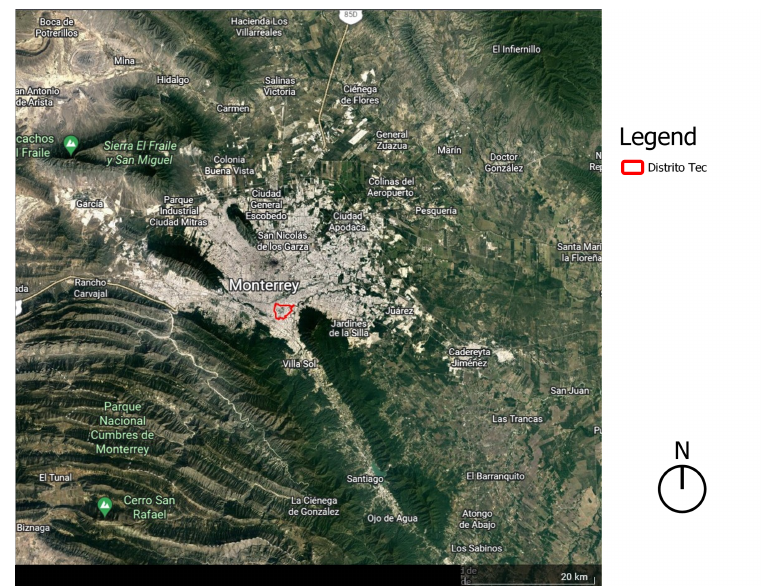
Figure 7. Distrito Tec within the Monterrey Metropolitan Area.